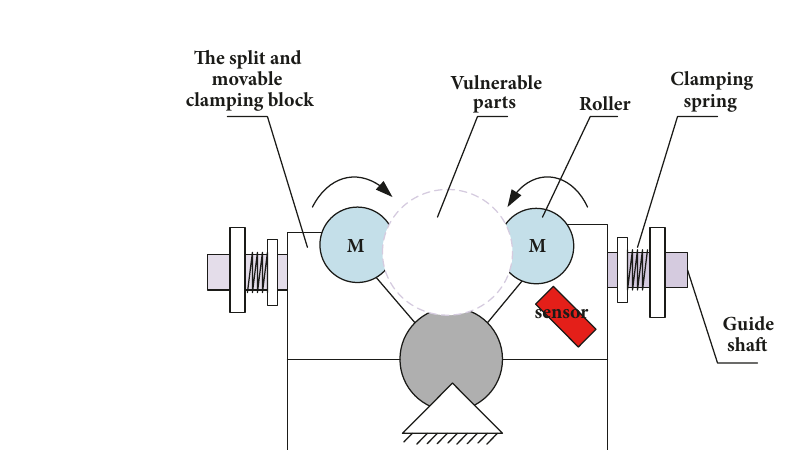
Figure 10: Improvement of the final object field model.